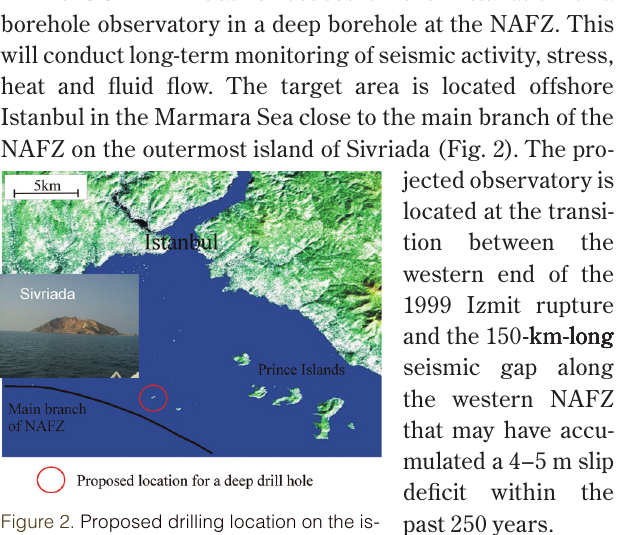
lines indicate major segments of the North Anatolian Fault Zone (NAFZ). Stars indicate major events that occurred in the last 2000 years.